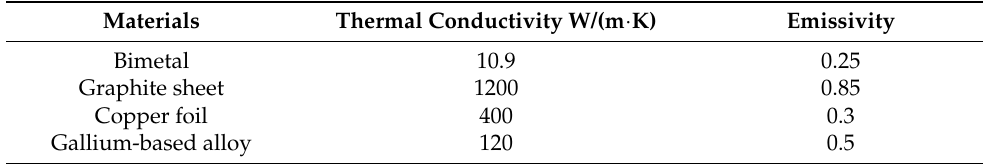
Table 1. Thermal conductivity and emissivity of thermal conductive materials.